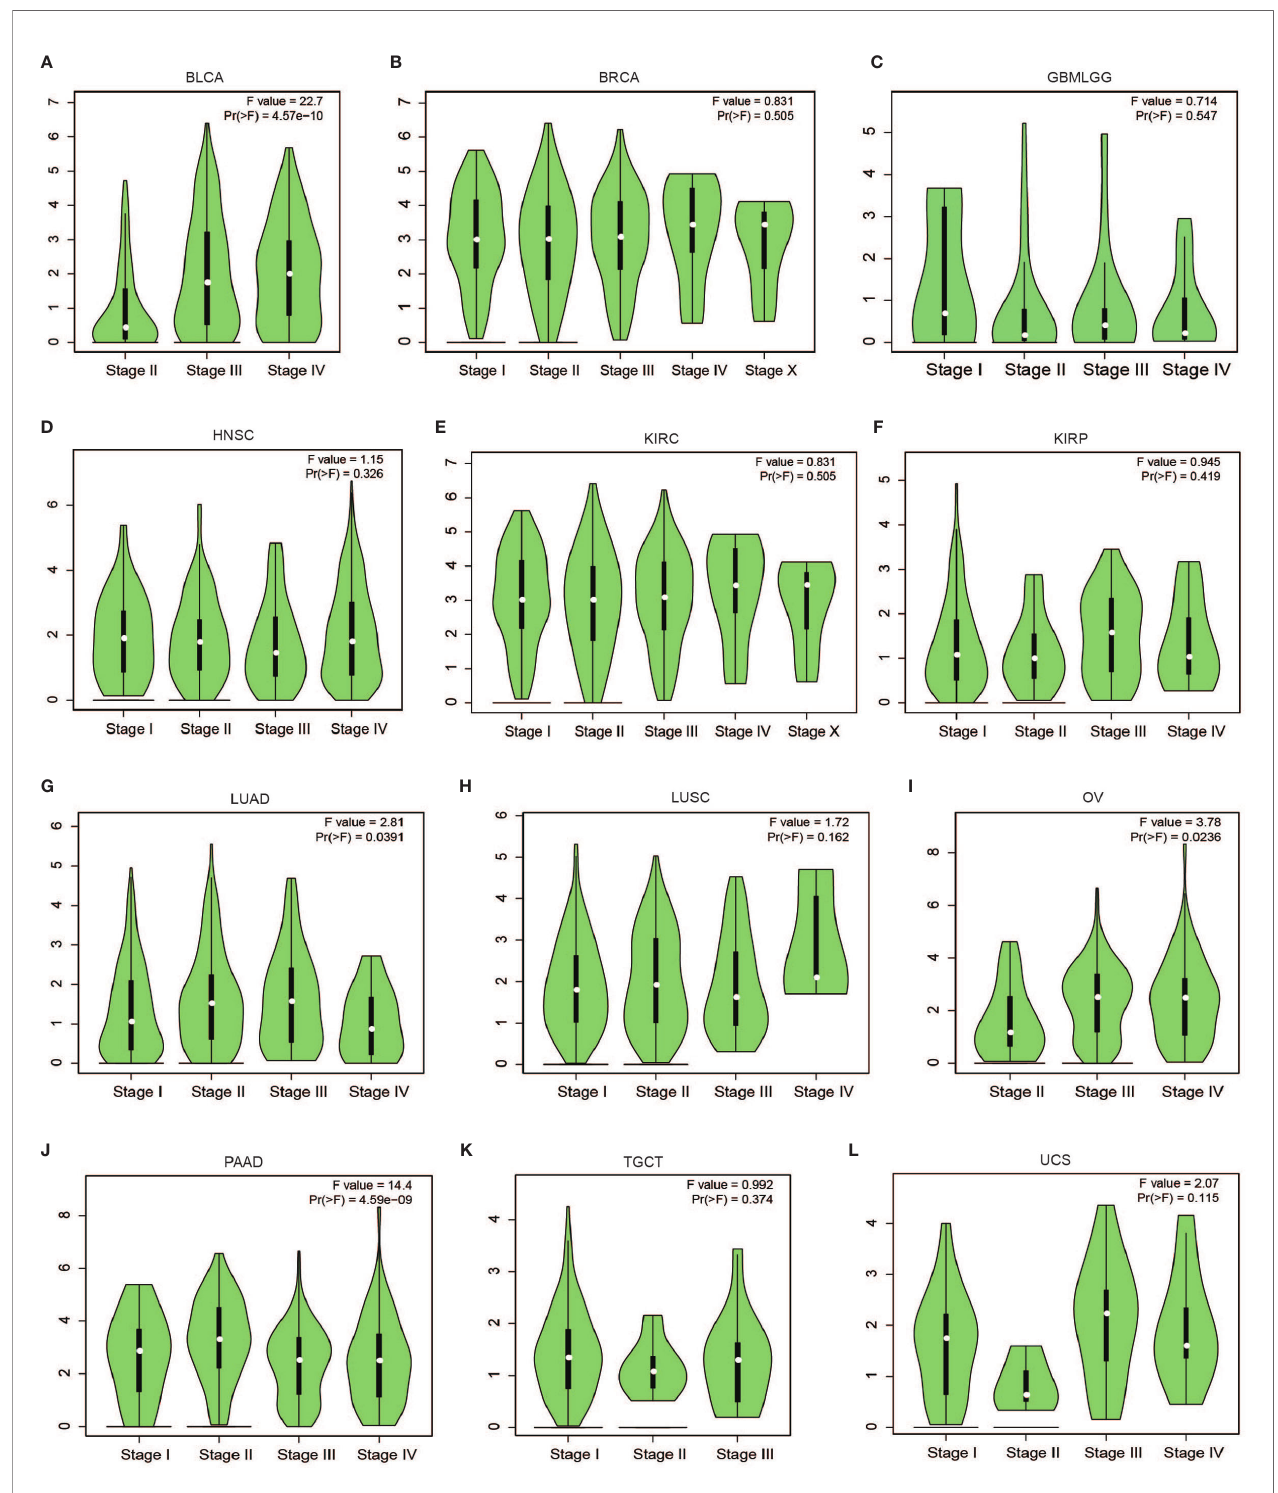
FIGURE 3 | Correlation between PLPP4 and the pathological stage of cancers (GEPIA). There was a signi fi cant correlation between PLPP4 expression level and the pathological stage of BLCA, LUAD, OV, and PAAD patients. (A – C) PLPP4 expression level and the pathological stage of BLCA, BRCA, and GBMLGG patients. (D – F) PLPP4 expression level and the pathological stage of HNSC, KIRC, and KIRP patients. (G – I) PLPP4 expression level and the pathological stage of LUAD, LUSC, and OV patients. (J – L) PLPP4 expression level and the pathological stage of PAAD, TGCT, and UCS